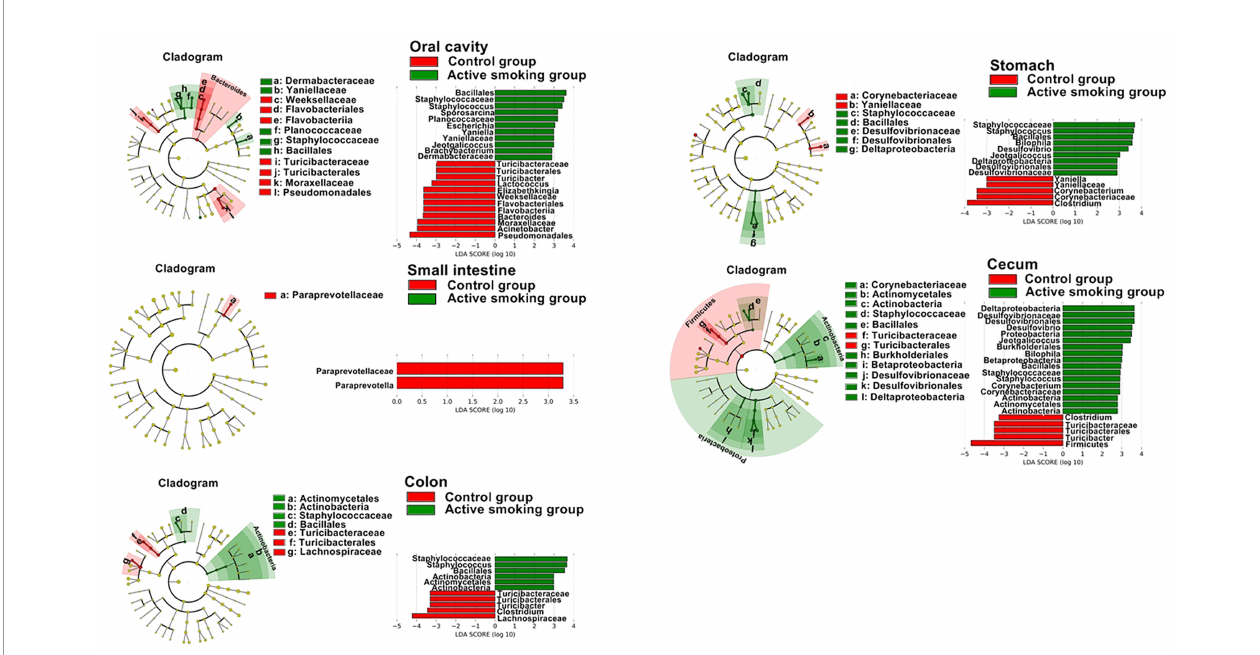
FIGURE 7 | Distinct active taxa identi fi ed in the oral cavity, stomach, small intestine, cecum, and colon according to smoking status using LEfSe analysis. Counts were analyzed using LEfSe to identify signi fi cant differences in bacterial abundance between the control group and active smoking group. Cladogram constructed using the LEfSe method to indicate the phylogenetic distribution of active bacteria that were remarkably enriched. LDA (Linear Discriminant Analysis) scores showed signi fi cant bacterial differences within groups at different taxonomic levels. Red represents the enriched taxa in the control group and green represents the enriched taxa in the active smoking